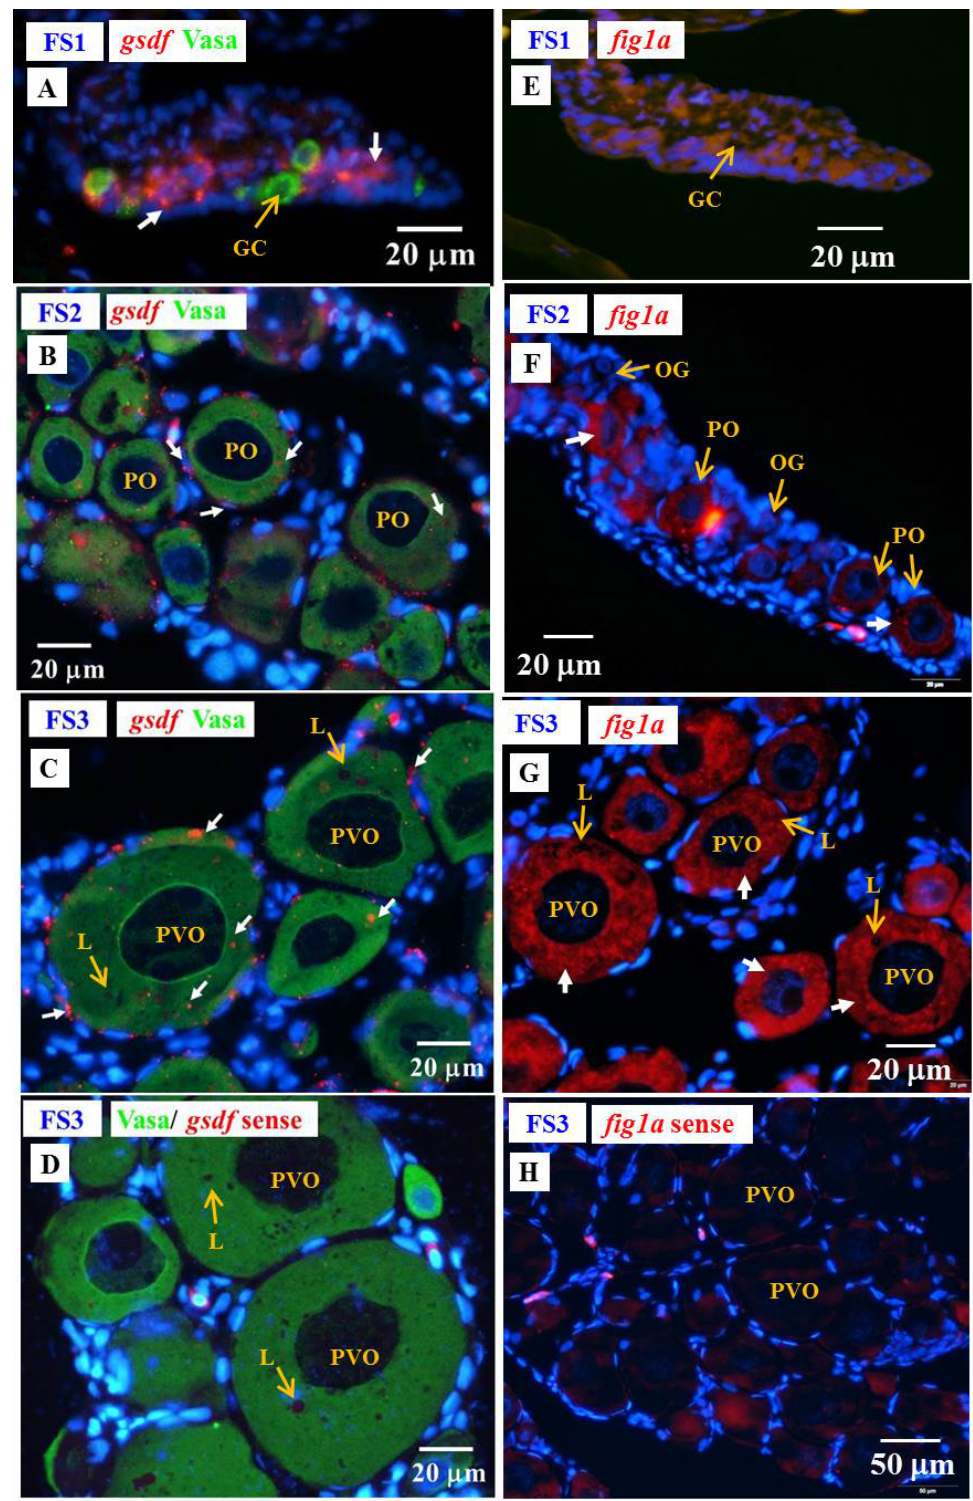
Figure 11. Gonad transverse sections, stained with ISH fluorescence for gsdf and figla transcripts (red staining, white arrow) and IHC for the Vasa proteins (green) gonads of E2-feminized Japanese eels at various stages of sexual differentiation. ( A ) gsdf at FS1 stage, undifferentiated gonad. ( B ) gsdf at FS2 stage, differentiating ovary. ( C ) gsdf at FS3 stage, differentiated ovary. ( D ) gsdf sense probe. ( E ) figla at FS1 stage. ( F ) fig1a at FS2 stage. ( G ) fig1a at FS3 stage. ( H ) fig1a sense probe. GC, germ cell; OG, oogonium; PO, primary oocyte; PVO, pre-vitellogenic oocyte; L, lipid droplet.